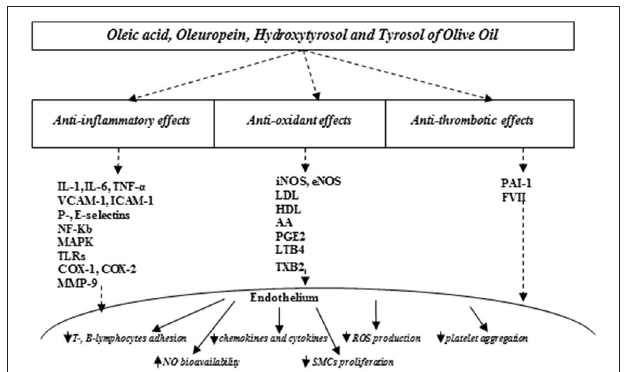
FIGURE 1 | Olive oil compounds modulating oxidative stress improve endothelial function. IL, interleukin-1; IL, interleukin-6; VCAM-1, vascular cell adhesion molecule-1; ICAM-1, intercellular adhesion molecule-1; NF-kB, nuclear factor kappa B; MAPK, mitogen-activated protein kinases; TLRs, toll-like receptors; COX-1, cyclooxygenase 1; COX-2, cyclooxygenase 2; MMP-9, matrix metalloproteinase-9; iNOS, inducible nitric oxide synthase; eNOS, endothelial nitric oxide synthase; LDL, low-density; HDL, high density lipids; AA, arachidonic acid; PGE2, prostaglandin E2; LTB4, leukotriene B4; TXB2, thromboxane B2, PAI-1, plasminogen activator inhibitor; FVII, factor VII; NO, nitric oxide; ROS, reactive oxygen species; SMCs, smooth muscle